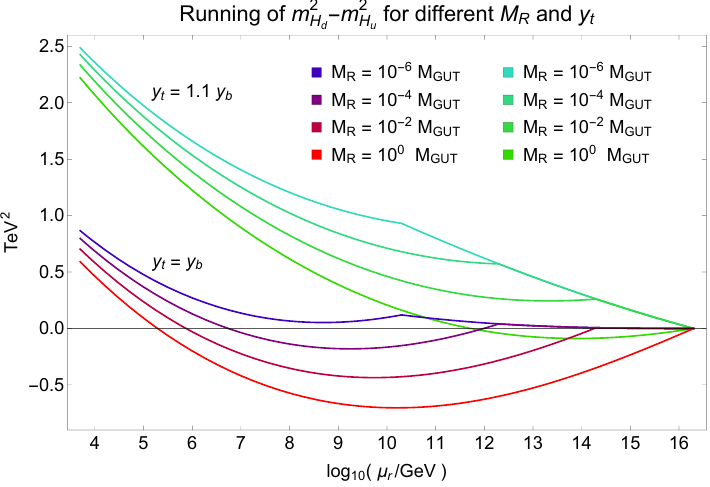
Figure 6 . The RGE running of m 2 (cid:0) m 2 for di(cid:11)erent values of the right-handed neutrino H d H u mass M R . The set of red-to-blue trajectories are for y t = y b ( t - b uni(cid:12)cation), while the green-to- cyan trajectories show the case y t = 1 : 1 y b . All other quantities are the same as in the example point